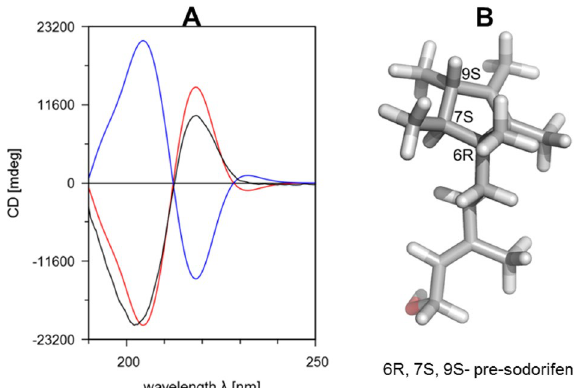
Figure 6. Determination of the stereochemistry of pre-sodorifen from the Serratia plymuthica sodorifen synthase (SODS) knockout mutant. ( A ) The CD spectrum (black line) coincides with the calculated CD-spectrum of 6R, 7S, 9S-pre-sodorifen (red line, similarity factor = 0.9972) while its enantiomer (blue line) does not. ( B ) Observed stereochemistry of pre-sodorifen.